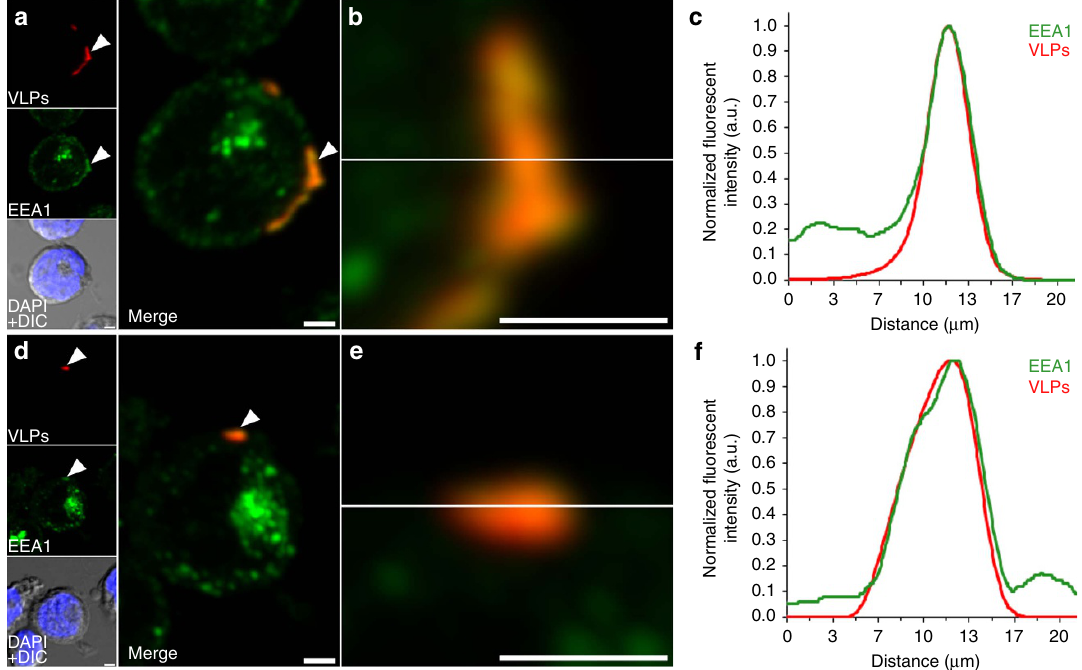
Figure 4 | Association of VP2-VLPs with EEA1-positive endosomes. Maximum intensity projections of serial confocal optical sections through Raji ( a ) and GM12878 cells ( d ) incubated overnight with VP2-VLP-AF647 (red) and treated with trypsin. White arrows represent enhanced cytoplasmic VLP localization in EEA1-positive endosomes (green). Differential interference contrast (DIC) merged with DAPI (blue) images are shown. Areas of localization (yellow) ( b , e ) and normalized fluorescent intensity profiles in zoomed areas ( c , f ) indicate VLP internalization. Scale bars, 2 m